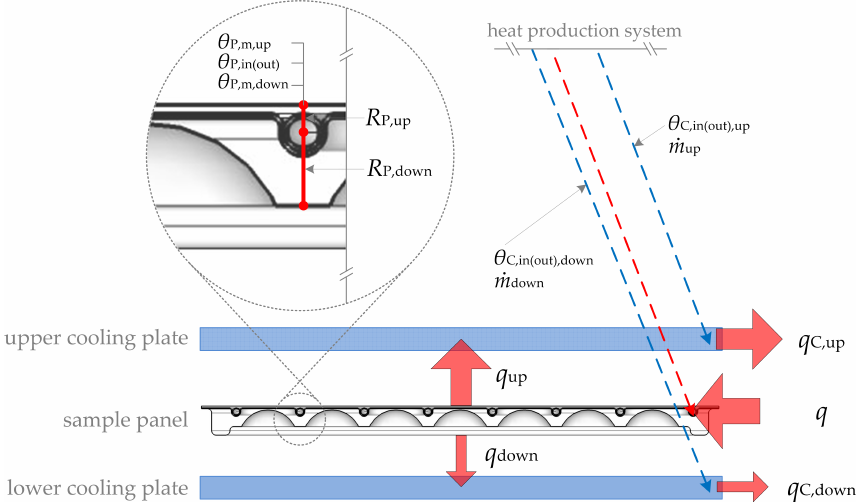
Figure 4. Factors related to the heat flux in the experimental configuration and the heat balance thereof in the steady-state experiment, using the modified method. (in steady-state condition, q = q up + q down , q up = q C,up , and q down = q C,down